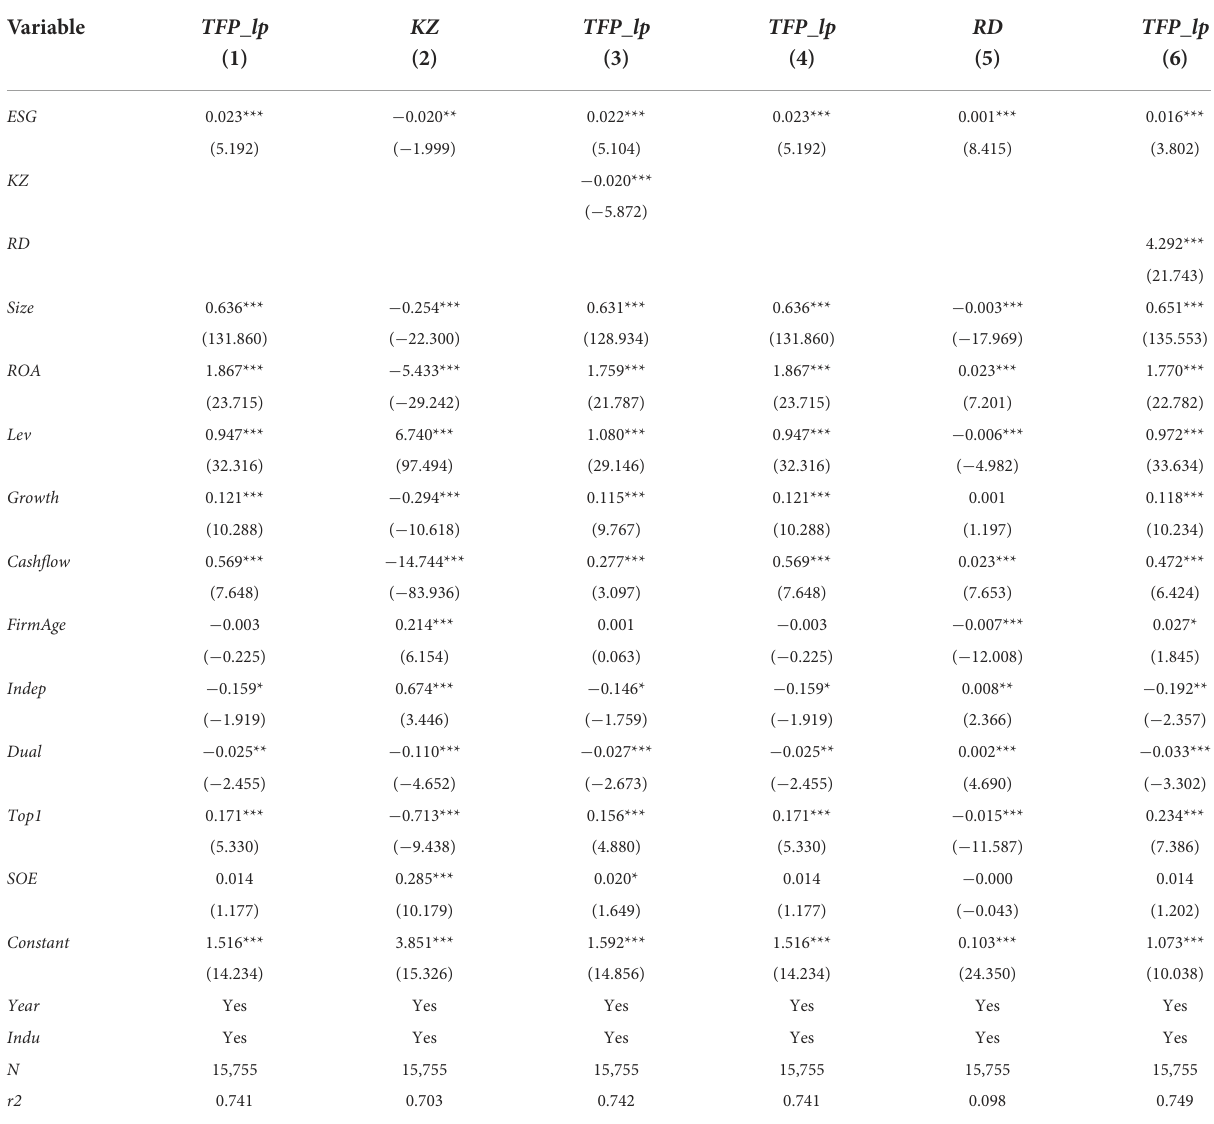
TABLE 4 Mechanism